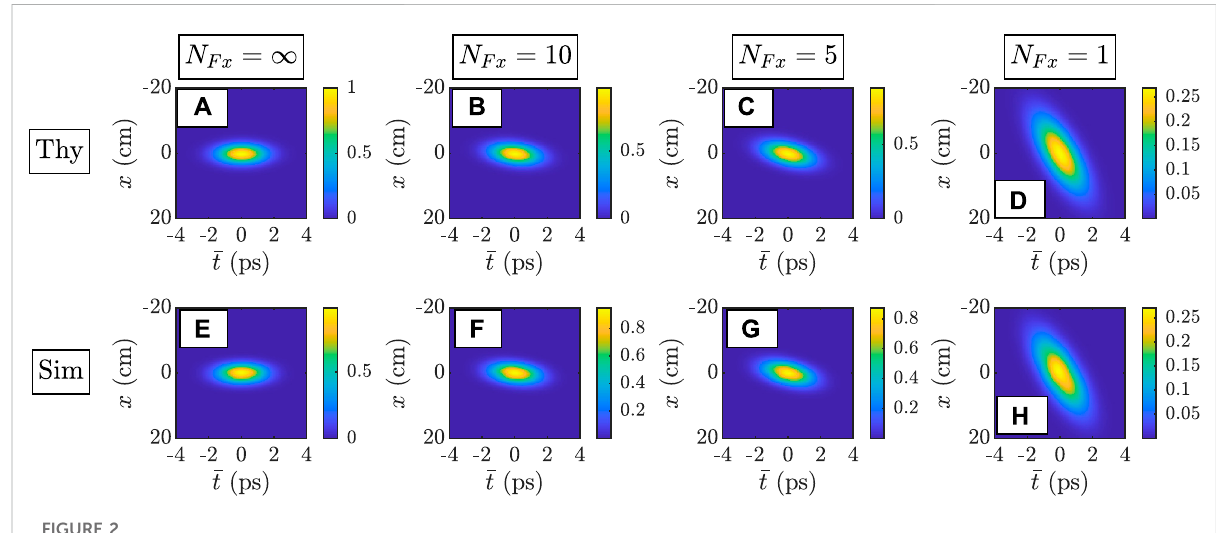
FIGURE 2 Ensemble-averaged irradiance 〈 I ( x , 0 , z , t ) 〉 free-space results: (A) theory N Fx = ∞ , (B) theory N Fx = 10, (C) theory N Fx = 5, (D) theory N Fx = 1, (E) simulation N Fx = ∞ , (F) simulation N Fx = 10, (G) simulation N Fx = 5, and (H) simulation N Fx = 1.